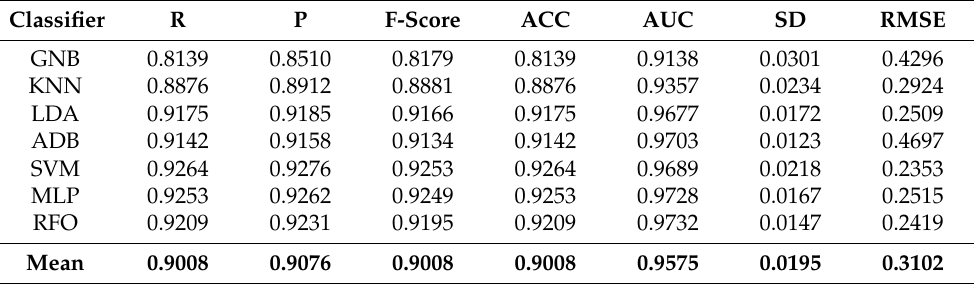
Table 1. Compartment prediction performance using various genomic marks of CTCF convergent loops for various classifiers (all 428 features are considered for